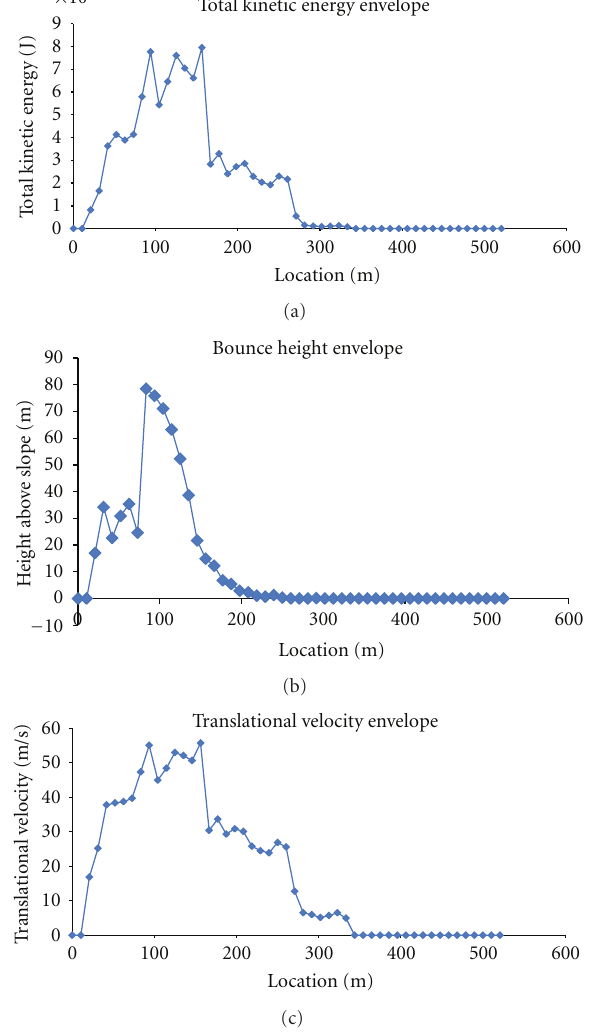
Figure 6: Example of analysis along the profile